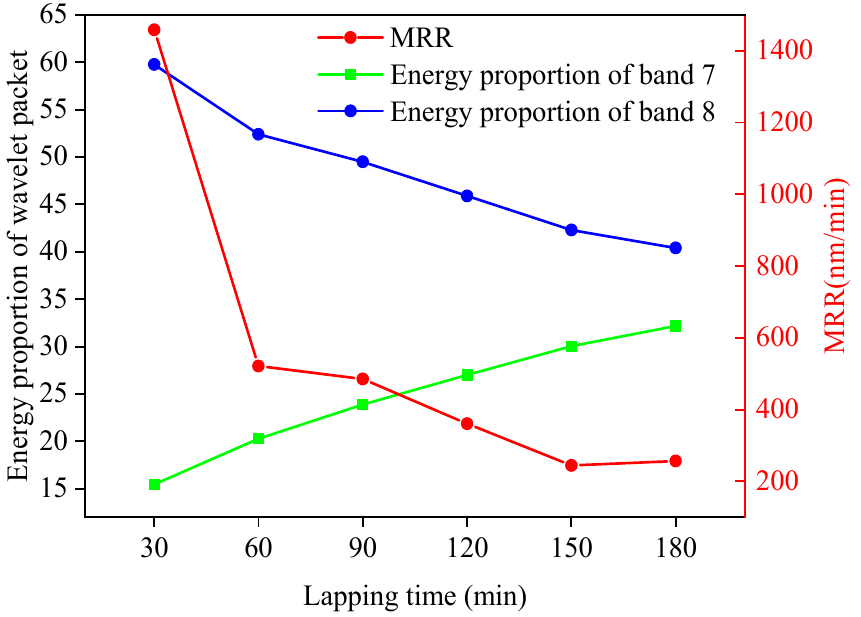
Figure 5. Proportion of wavelet packet energy in each processing stage of the FAP. Note: ( a ) Lapping time 0–30 min; ( b ) lapping time 30–60 min; ( c ) lapping time 60–90 min; ( d ) lapping time 90–120 min; ( e ) lapping time 120–150 min; ( f ) lapping time 150–180